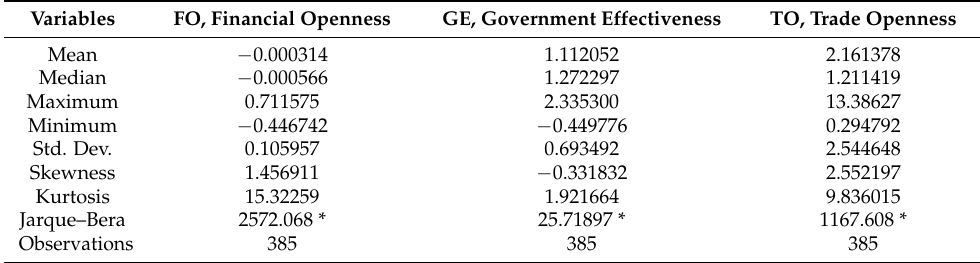
Table 1. Descriptive